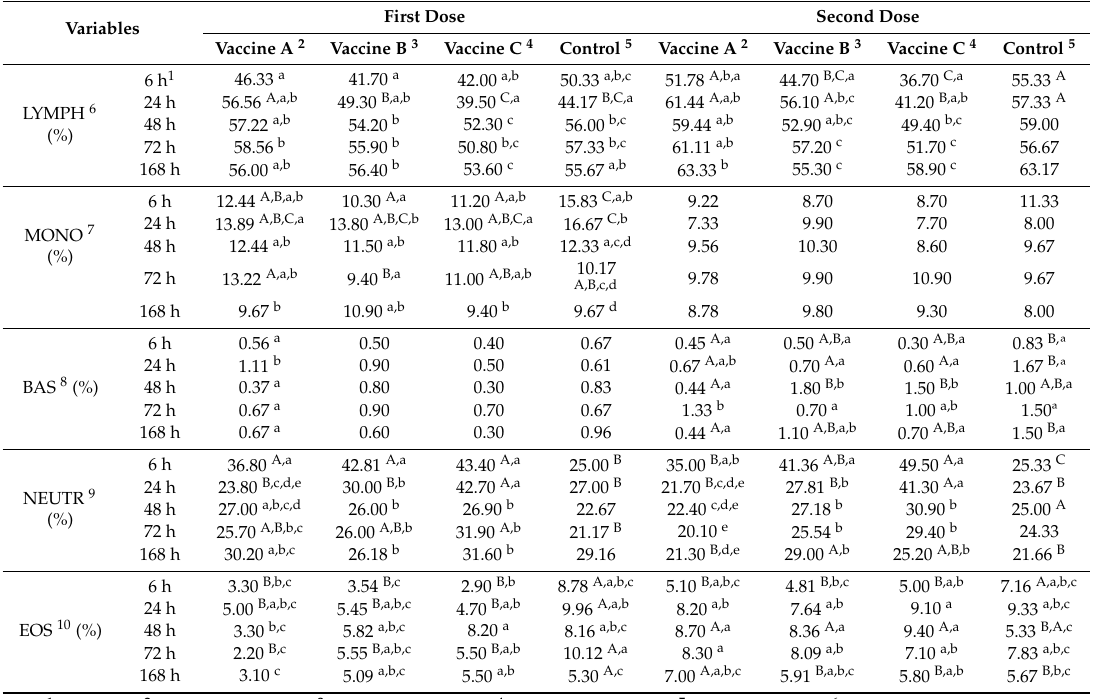
Table A4. Clinical pathology evaluated by relative mean values (%) obtained in the leukogram of animals vaccinated with vaccines against BVDV and BHV-1 with di ff erent commercial